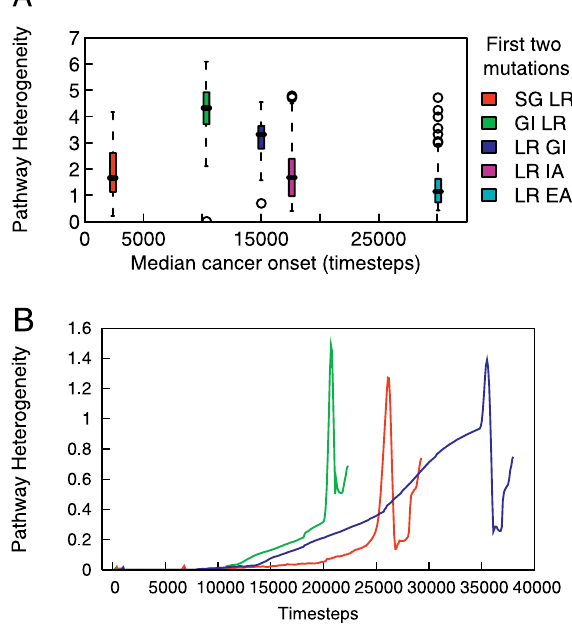
Figure 3. Tumor Heterogeneity (A) The five most common tumor categories, defined by the most common first two mutations, vary in their pathway heterogeneity. (B) Example dynamics of heterogeneity during the development of three tumors. Each line corresponds to the development of one tumor; the red curve corresponds to the tumor discussed in the Sample Simulation Run section. As the tumor begins to form, there is typically a slow increase in the degree of tissue heterogeneity followed by a sudden increase, an equally sudden decrease, and then often another increase as the tissue reaches 9 3 10 5 cells. DOI: